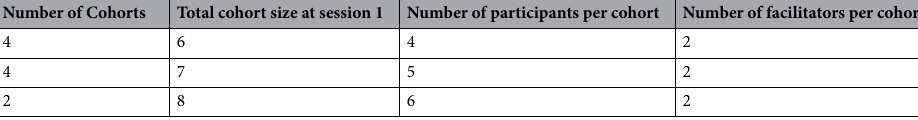
Table 1. Number of people per